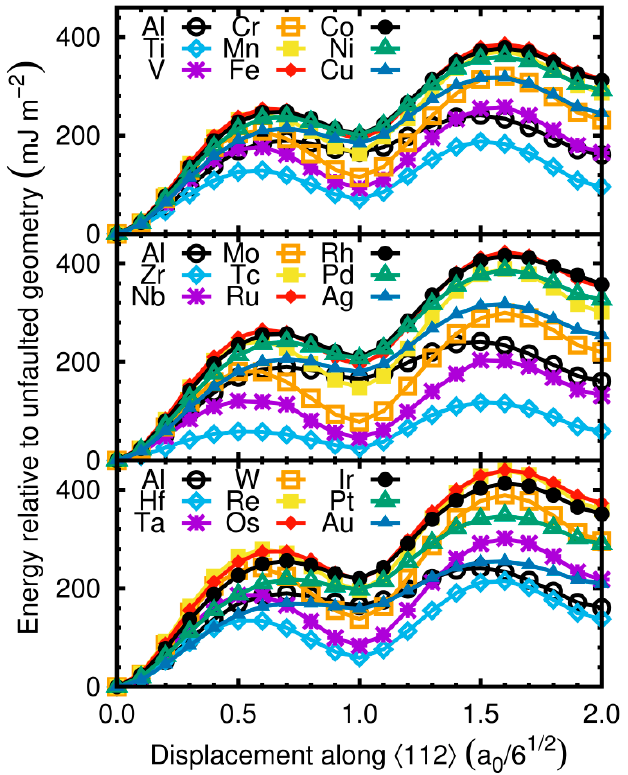
Figure 2. Generalized stacking fault energies(GSFEs) of selected aluminum-transition metal alloys. 3d, 4d and 5d elements are plotted from the bottombox to the top box, respectively. GSFEs of thesystem without the alloying element (Al) are shown on each plot for comparison.